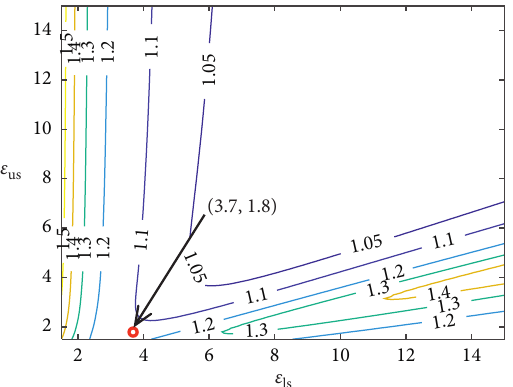
Figure 11: Contour plot of R a ui with various ε ls and ε us (Case 2).